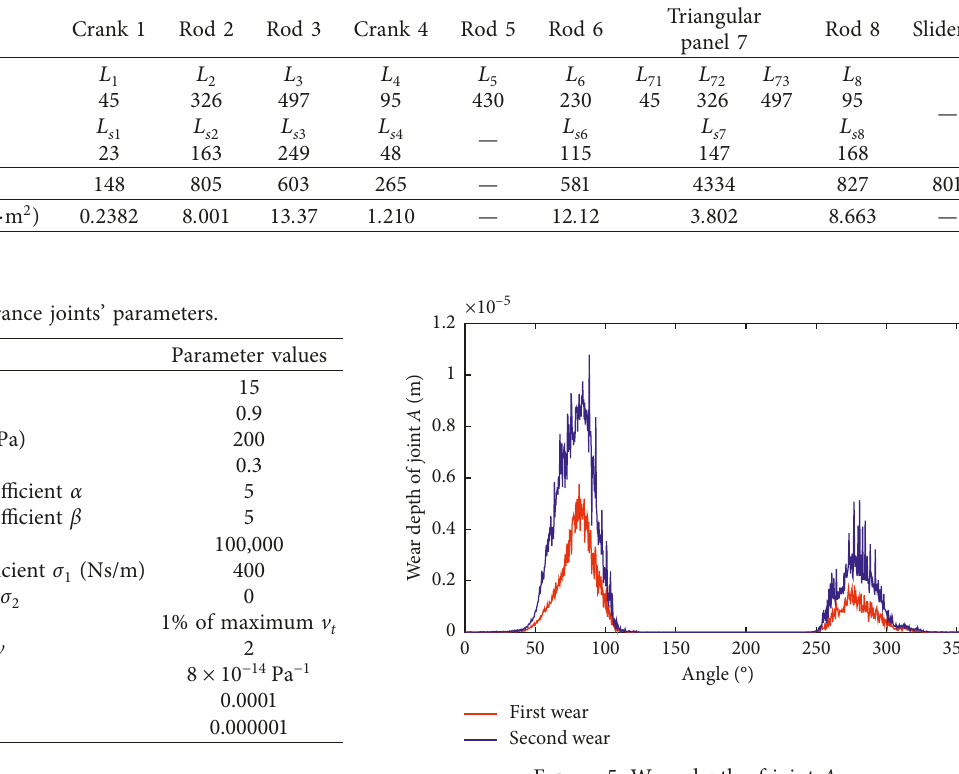
Figure 5: Wear depth of joint A